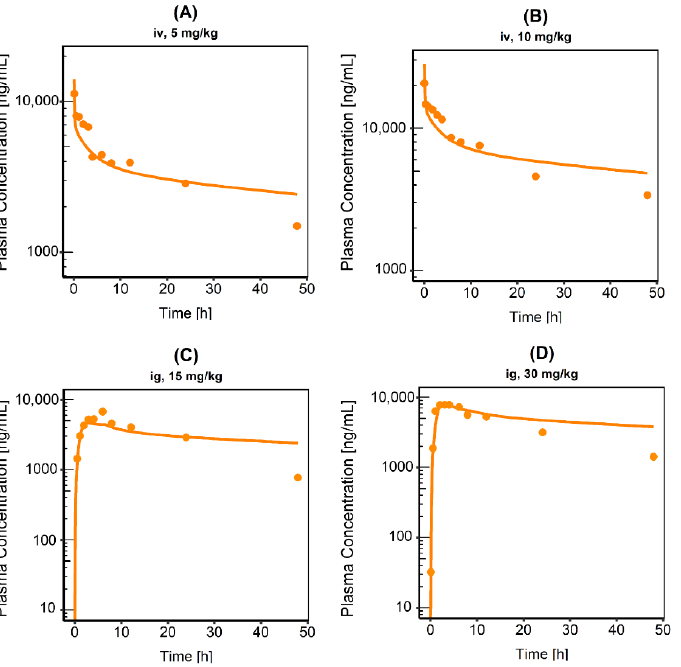
Figure 1. Semi-logarithmic plots of plasma concentration time profiles following ( A ) 5 mg/kg intravenous (iv), ( B ) 10 mg/kg iv, ( C ) 15 mg/kg intragastric (ig) or ( D ) 30 mg/kg ig administration of CAB. Observed data are shown as dots, simulations are shown as lines. All data extracted from Wang et al., n = 8 in every case.